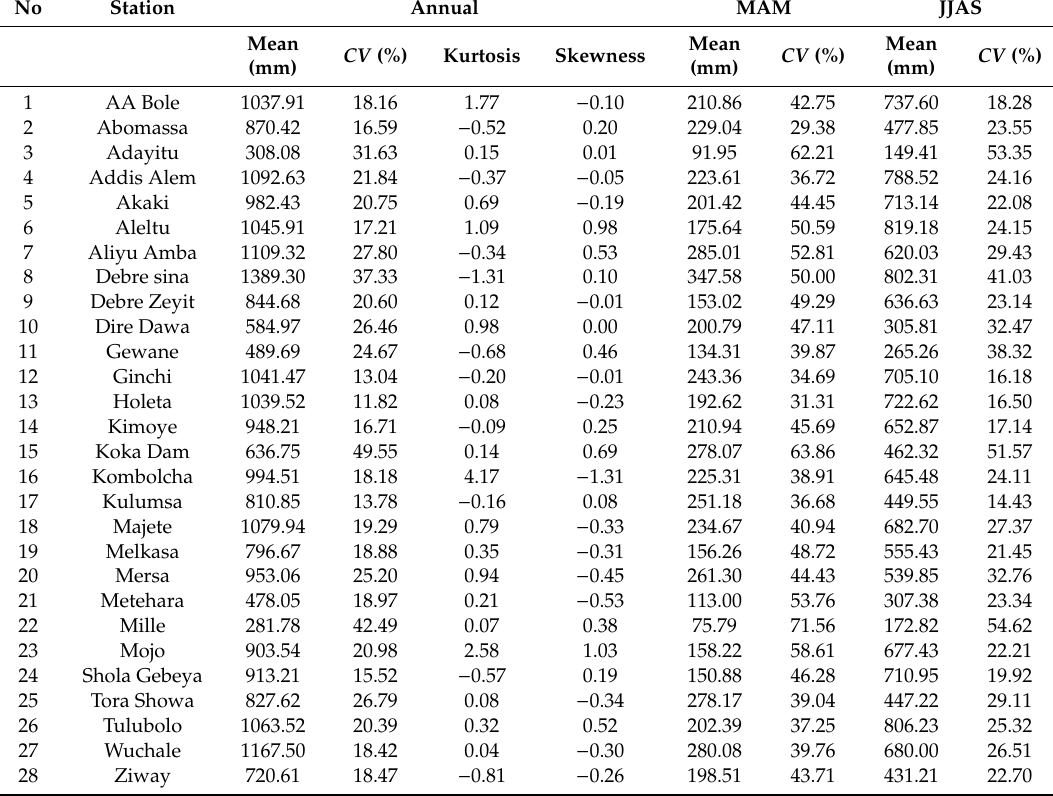
Table 1. Summary of descriptive statistics of rainfall in ARB .